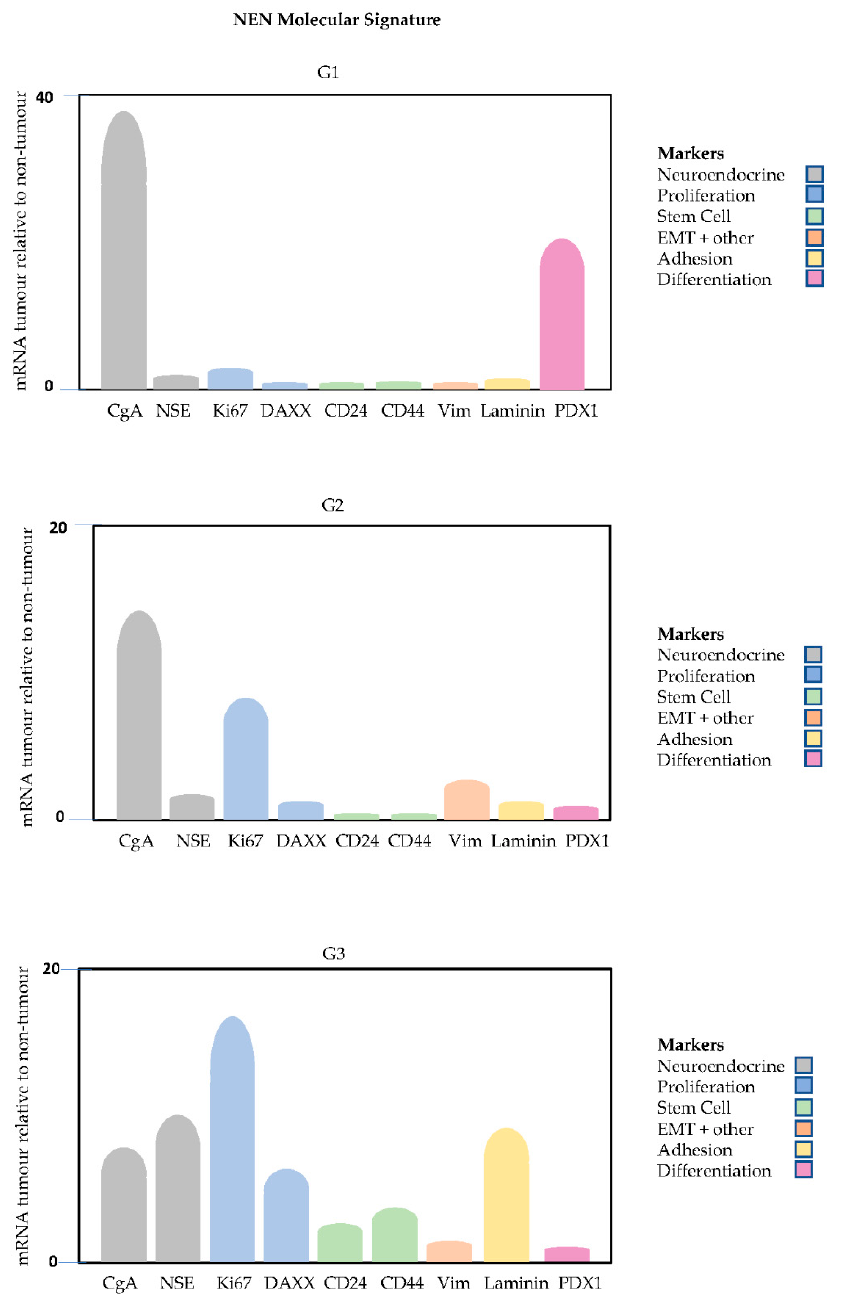
Figure 4. Molecular fingerprint depicting the pattern of the mean mRNA levels in tumour tissue relative to those in non-tumour for each marker across three grades for different categories of markers including neuroendocrine, proliferation, stem cell, multifunctional including EMT (EMT+), adhesion and differentiation .